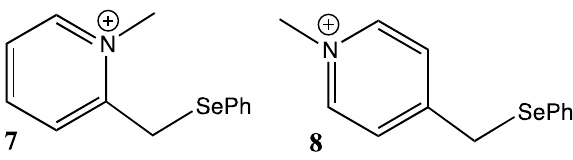
Figure 2. Selenium substituted pyridinium ions.